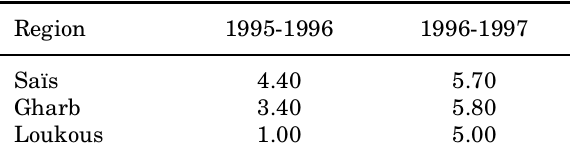
region-wide incidences of mildewed plants were